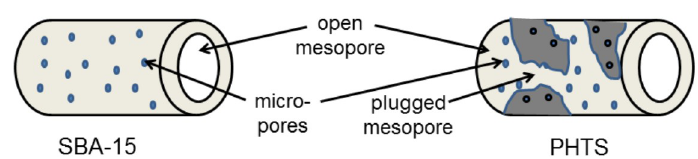
Figure 3. Nitrogen adsorption-desorption isotherms at − 196 ◦ C for MCM-41(S); MCM-41(HO); MCM-48; SBA-15; PHTS and MCF.